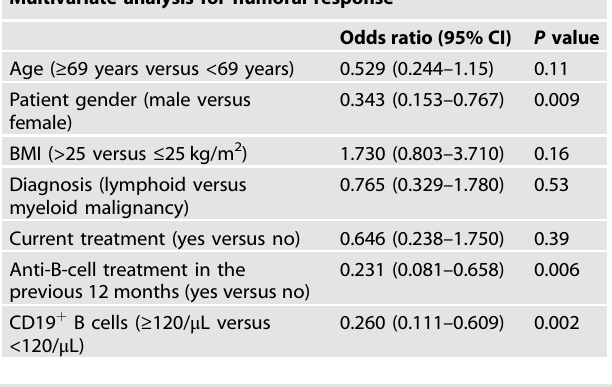
Table 2. Multivariate analysis for humoral response and T-cell